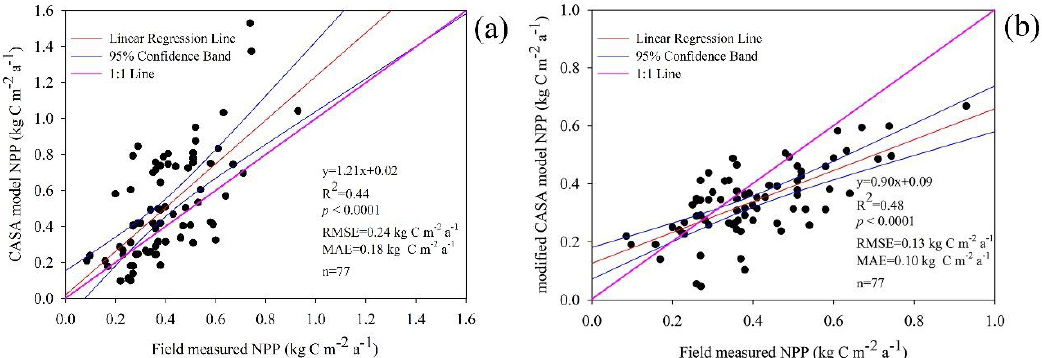
Figure 1. Validation of net primary productivity (NPP) of field measurements, and NPP estimated from ( a ) the original Carnegie–Ames–Stanford Approach (CASA) model, as well as ( b ) the modified CASA model, between 2001 and 2015. Note that the 95% confidence intervals of slopes for the CASA model and modified CASA model ranges from 0.90 to 1.53 and between 0.69 and 1.12, respectively.